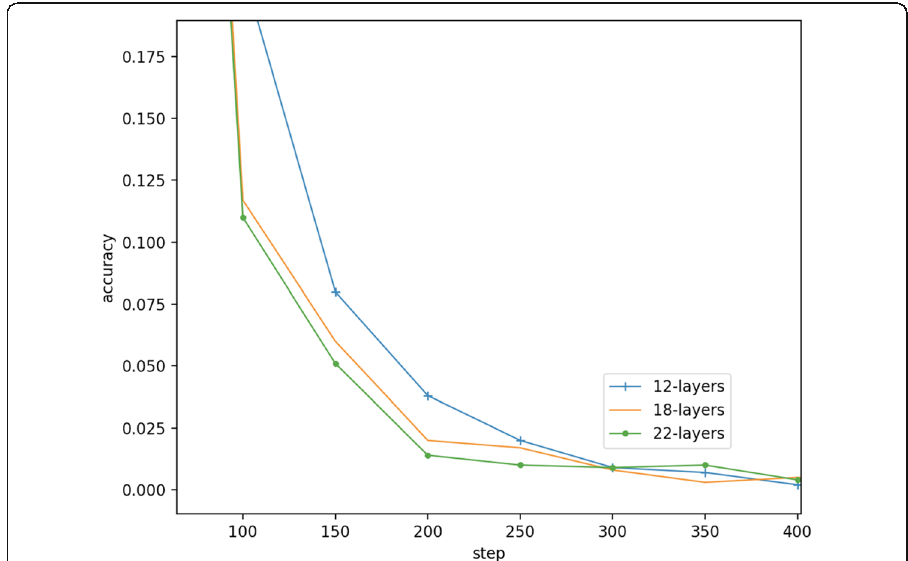
Fig. 10 Details of loss under different